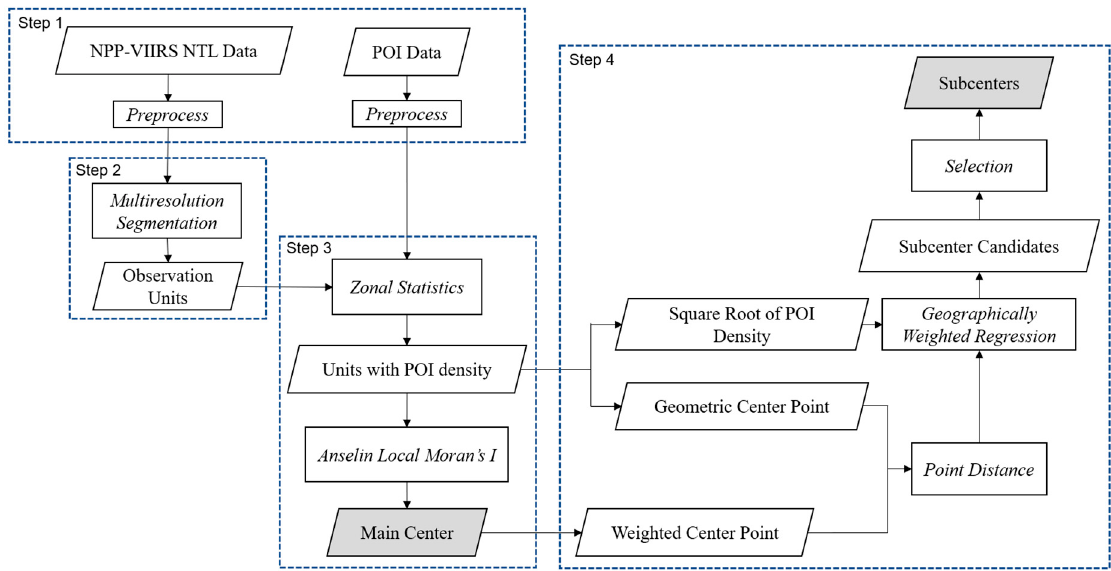
Figure 3. Workflow of the proposed method. NTL: nighttime light; NPP-VIIRS: visible infrared imaging radiometer suite.